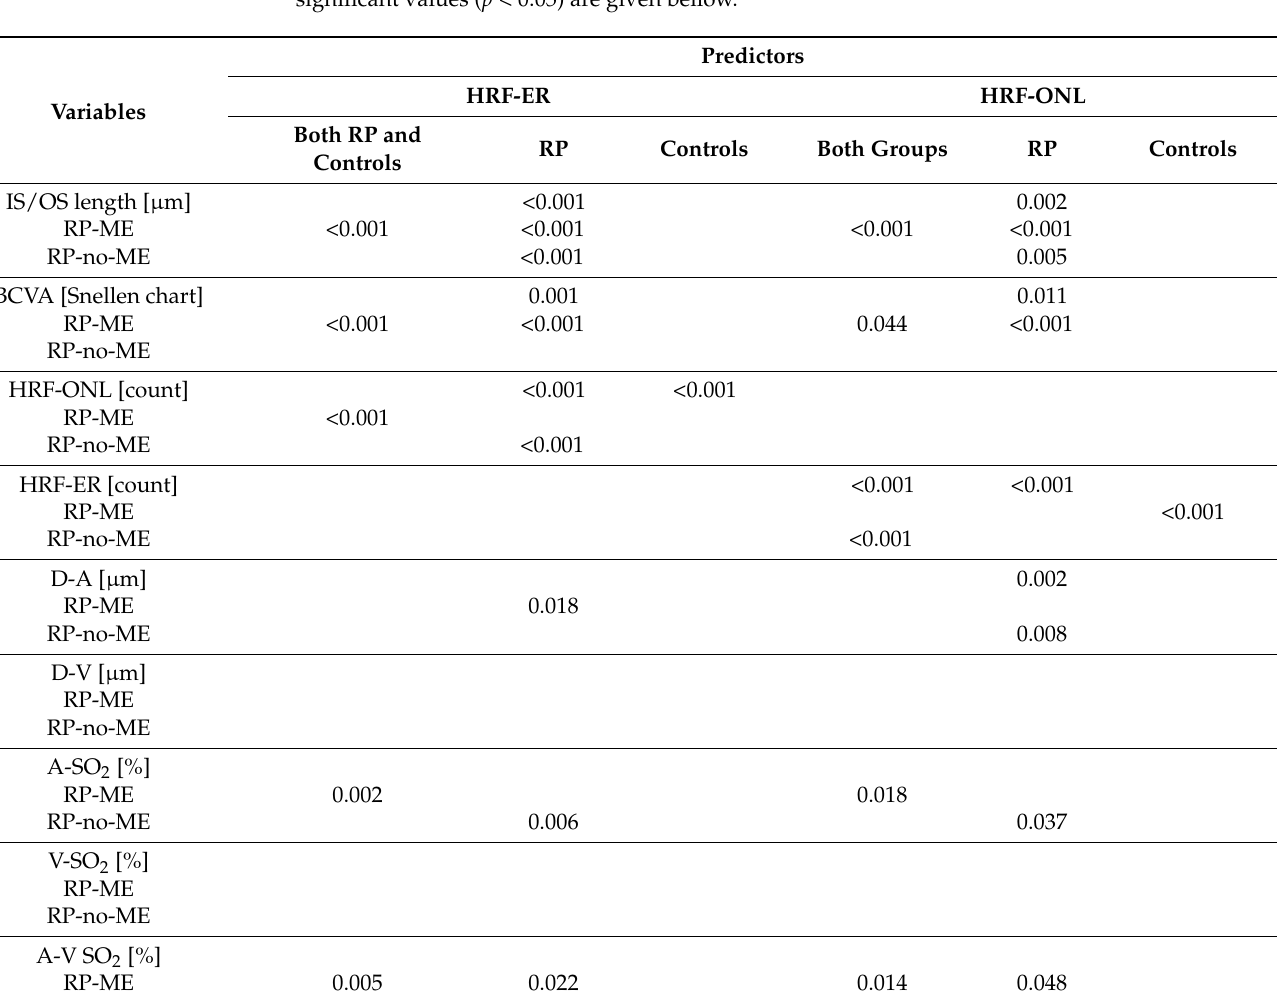
Table 3. presenting interactions between the number of HRF (HRF-ER and HRF-ONL) and the functional, structural and metabolic findings taking the group-effect into account. Only statistically significant values ( p < 0.05) are given